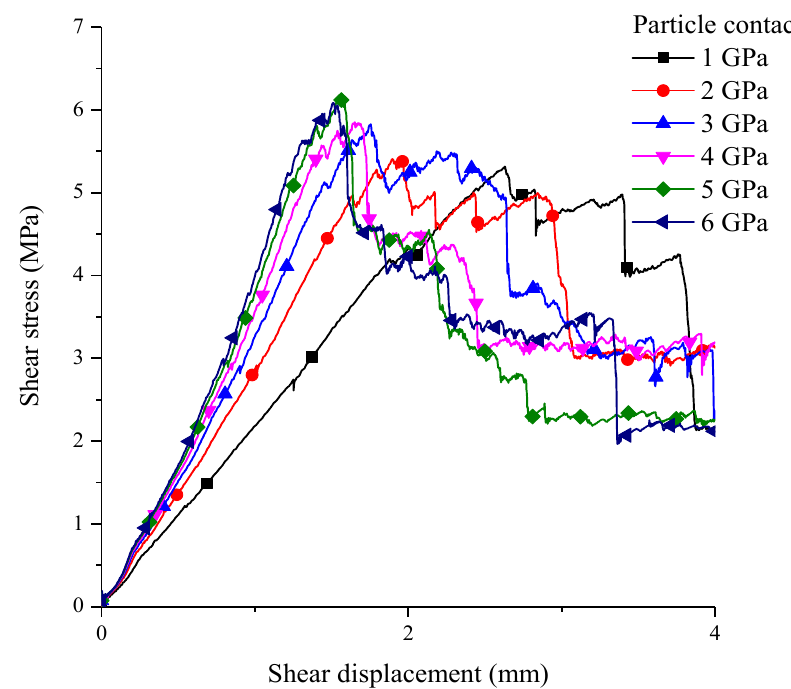
Figure 9. The shear stress–shear displacement curve under different values of particle contact modulus.